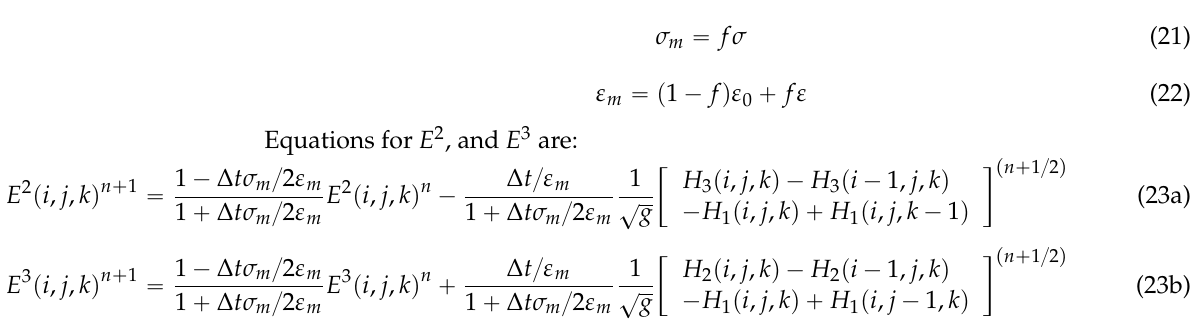
E 2 , and E 3 , are obtained using the modified conductivity and permittivity σ m , ε m :